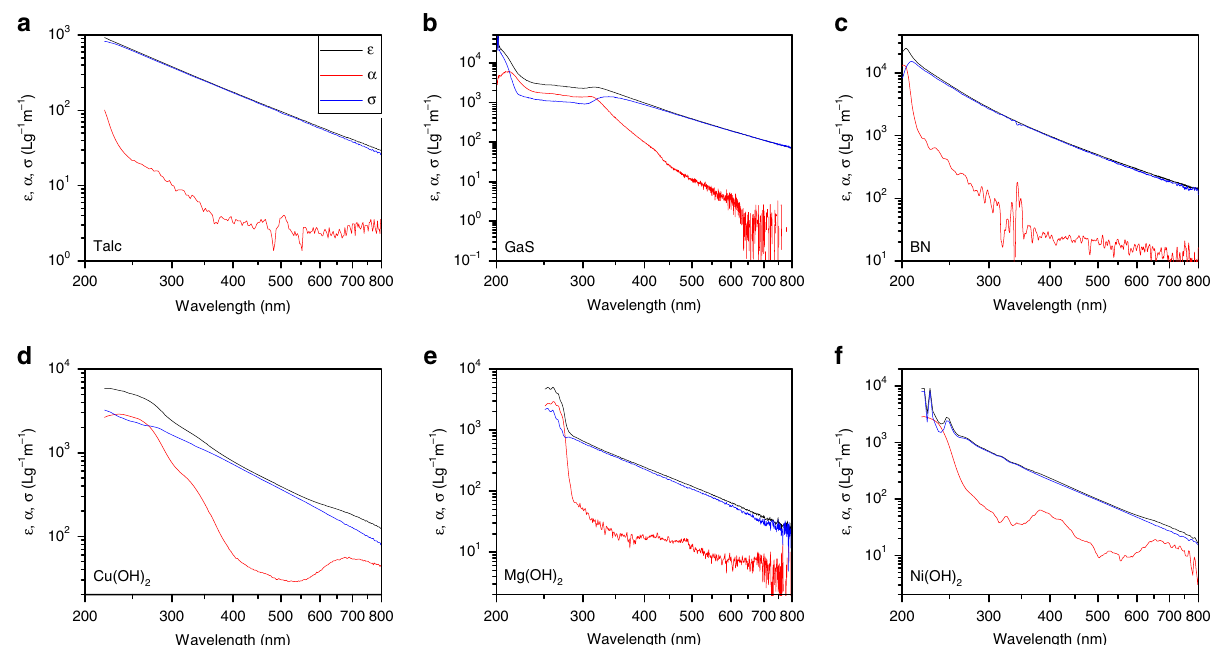
Fig. 4 Optical coef fi cient spectra for size-selected nanosheets of each material. Each plot shows optical extinction ( ε , black), absorption ( α , red) and scattering ( σ , blue) coef fi cient spectra. In each case, the spectra are shown for the small (S)